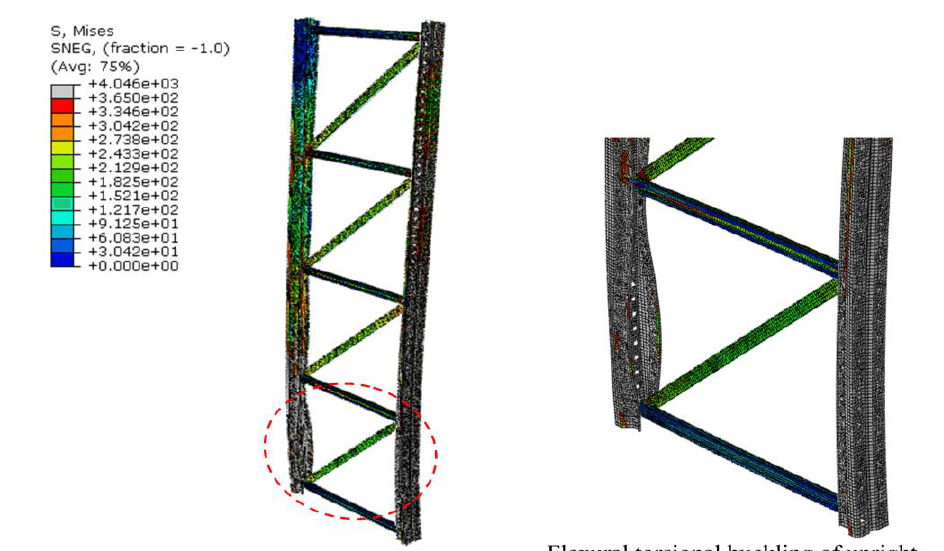
Fig. 14. B2-1.6 mm MW frame von Mises stress contours at an instant of maximum top displacement. The von Mises stress contours for 1.6 mm thick B1 and B2 types of storage rack systems are